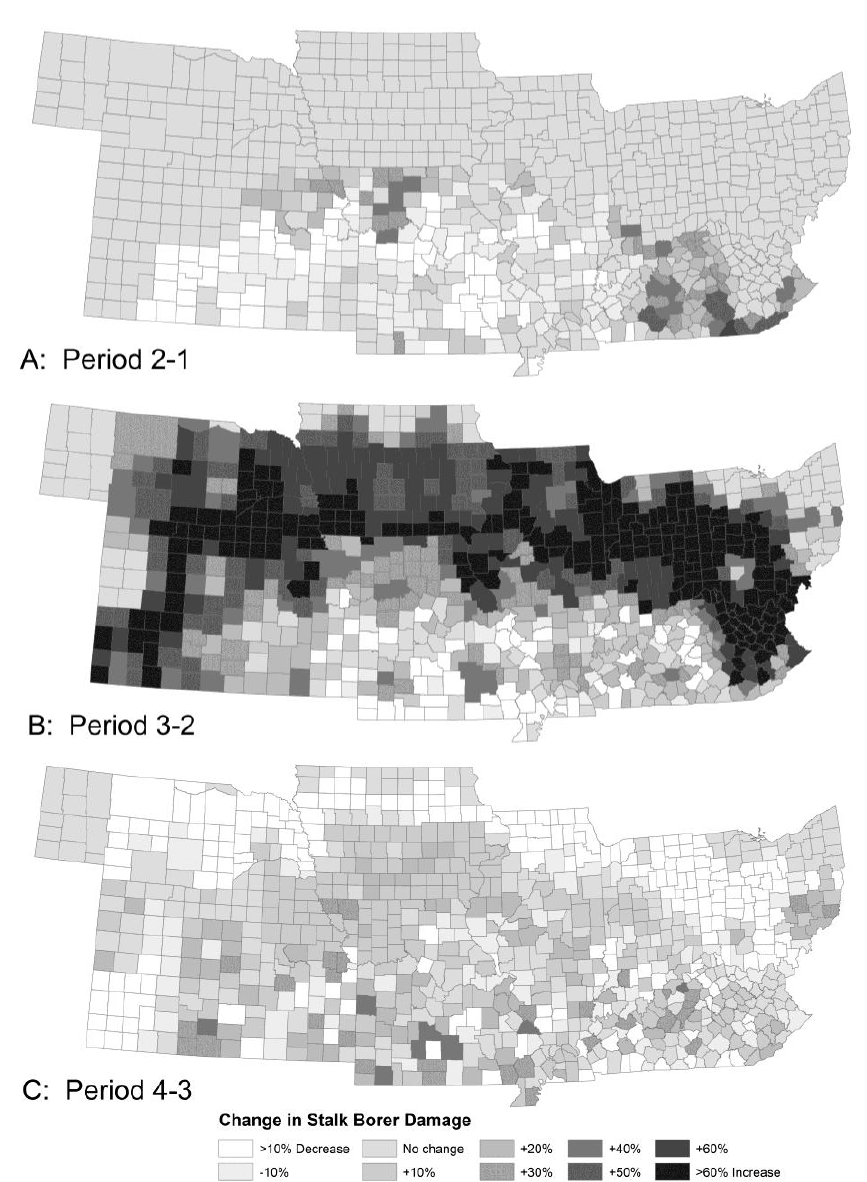
Figure 3. The model predicted little change in crop damage ( A ) by stalk borer (without insecticides) from Period 1 to 2, except for an area in Eastern Kentucky, large increases in crop damage ( B ) across the region from Period 2 to 3 and a small recovery ( C ) from Period 3 to 4. Damage by Mexican bean beetle was similar in overall pattern but differed in detail.